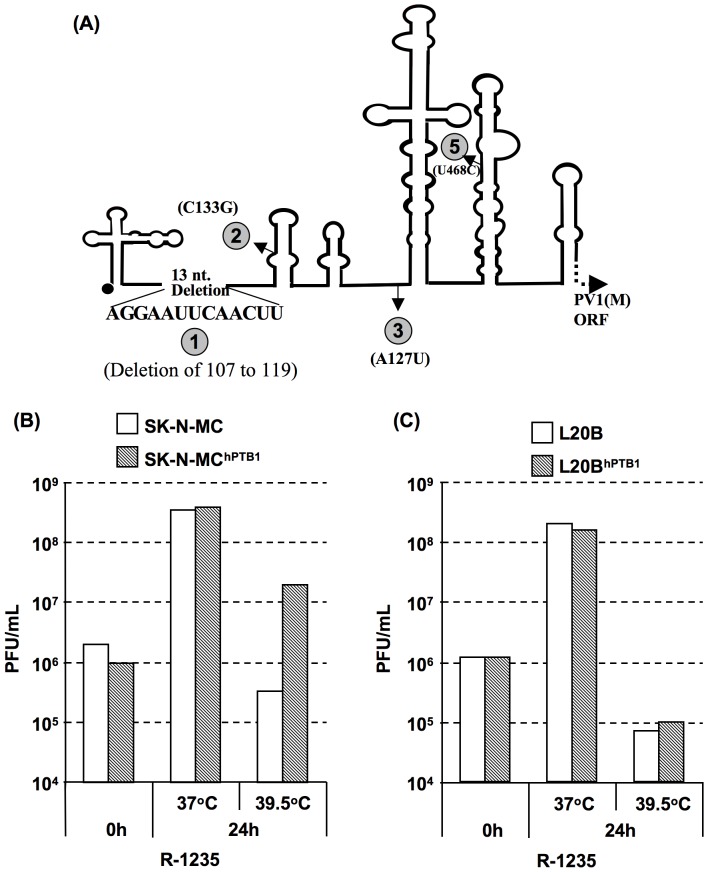
Effect of hPTB1 supplementation on the growth of R-1235 virus.(A) Schematic representation of the IRES of R-1235 virus. The changes in nucleotides in the 5′NTR and in the IRES are indicated and they are numbered as 1, 2, 3, and 5. (B) Comparison of the growth phenotype of R-1235 virus in the parental SK-N-MC cells and with that in SK-N-MChPTB1 cells at 37°C and 39.5°C, at an MOI of 10. The bars show the average of two independent experiments. (C) Comparison of the growth phenotype of R-1235 virus in the parental L20B cells and with that in L20BhPTB1 cells at 37°C and 39.5°C, at an MOI of 10. The bars show the average of two independent experiments.